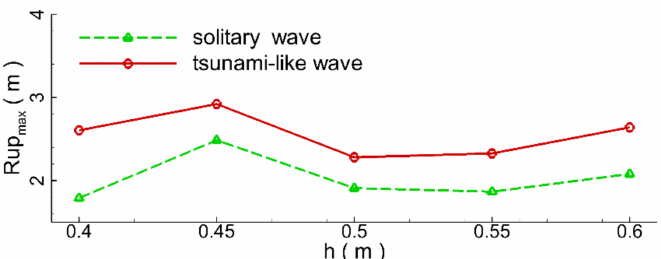
Figure 22. Variations in the maximum wave runup height with the still water depth.